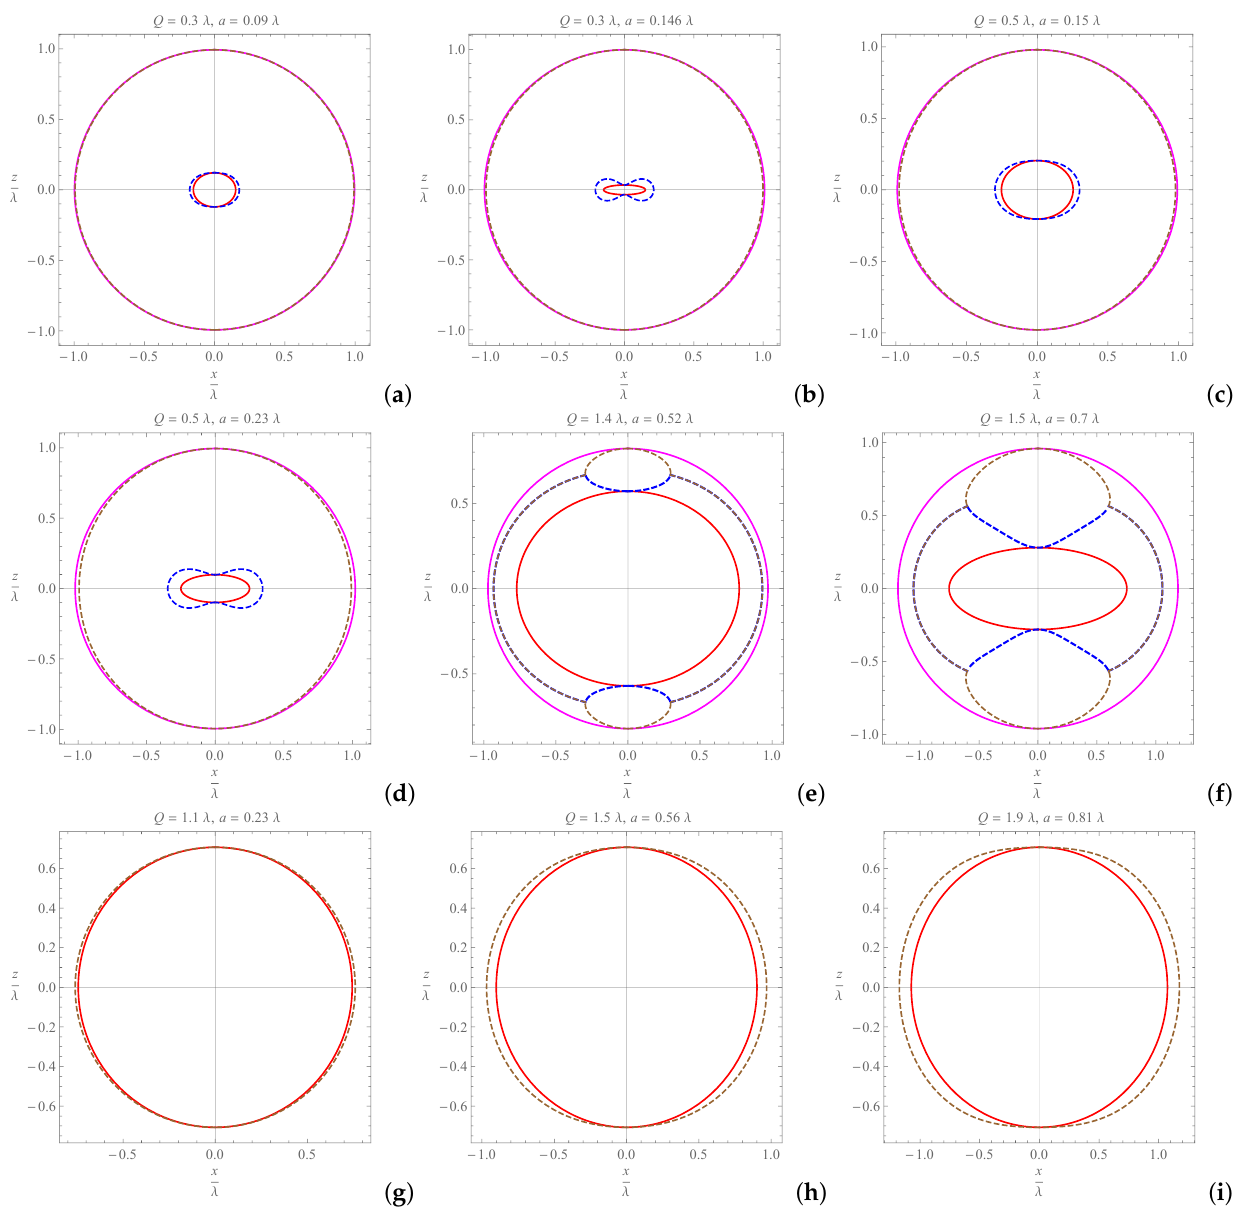
Figure 4. The hypersurfaces corresponding to the horizons and the static limit, plotted for λ = 10 and several fixed values of Q and a , as viewed from the y axis. The axes are given in terms of dimension-less values z / λ and x / λ . In the ( a – f ) diagrams, the smaller and the larger solid contours correspond respectively, to r + and r ++ , whereas the smaller and the larger dashed ones relate to r SL 1 (the static limit) and r SL 2 . The region r + < r < r SL 1 indicates the ergosphere in each of the cases. The figures were scaled so that the r ++ surface appears as a complete circle. The ( g – i ) diagrams demonstrate the ergoregion in the case of the extremal black hole. The solid and the dashed contours correspond, respectively, to r ex and r SL ( ex )